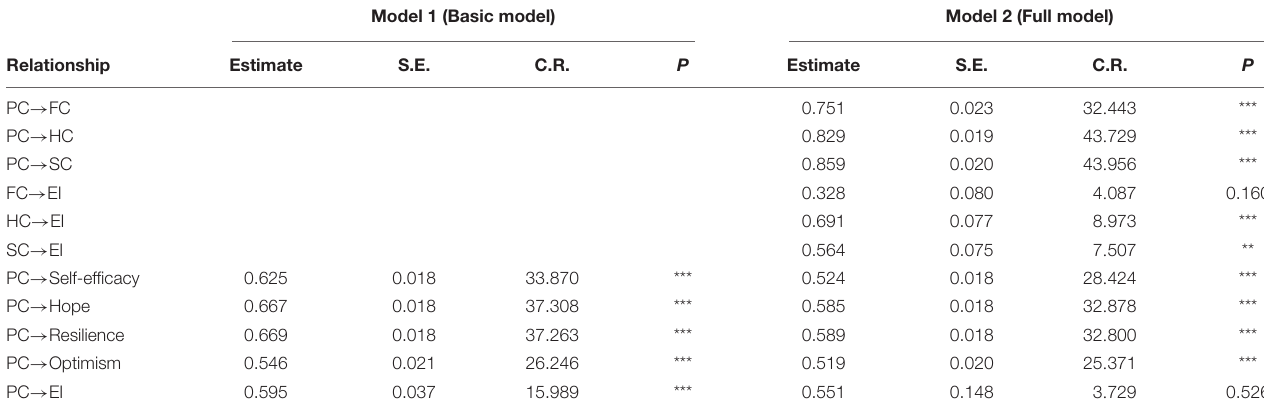
TABLE 3 | Structural model results.